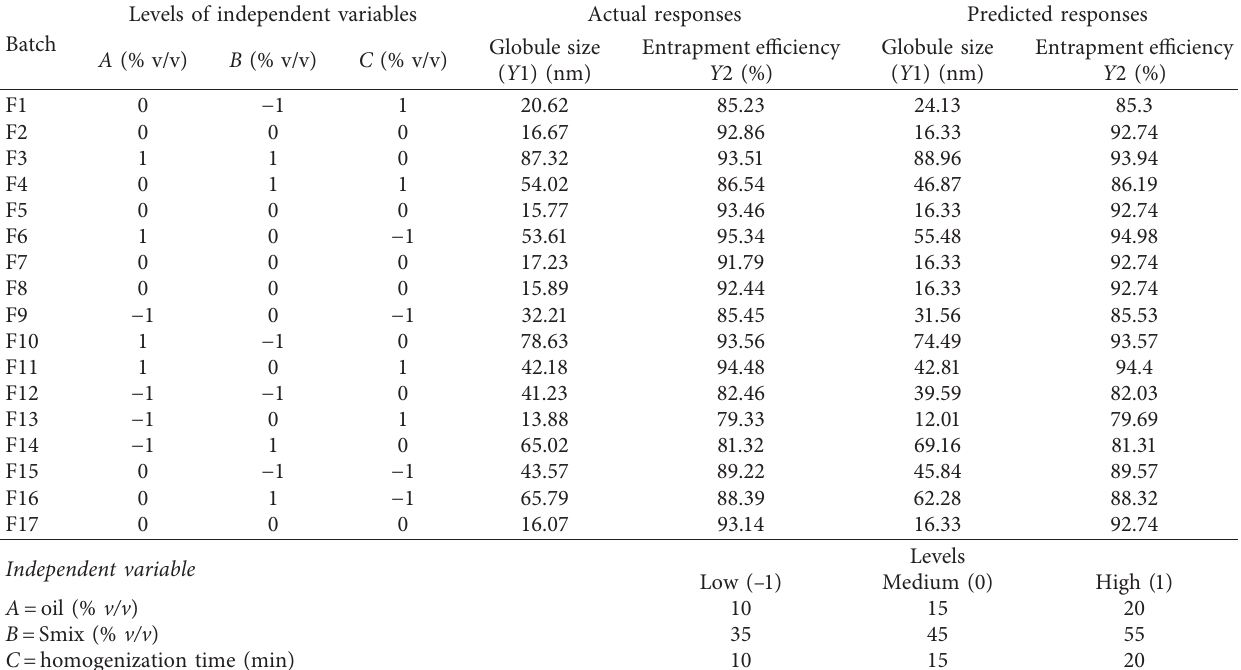
Table 1: Box–Behnken statistical design: levels of three independent variables from the experimental runs along with the predicted responses on LUL-loaded nanoemulsion.